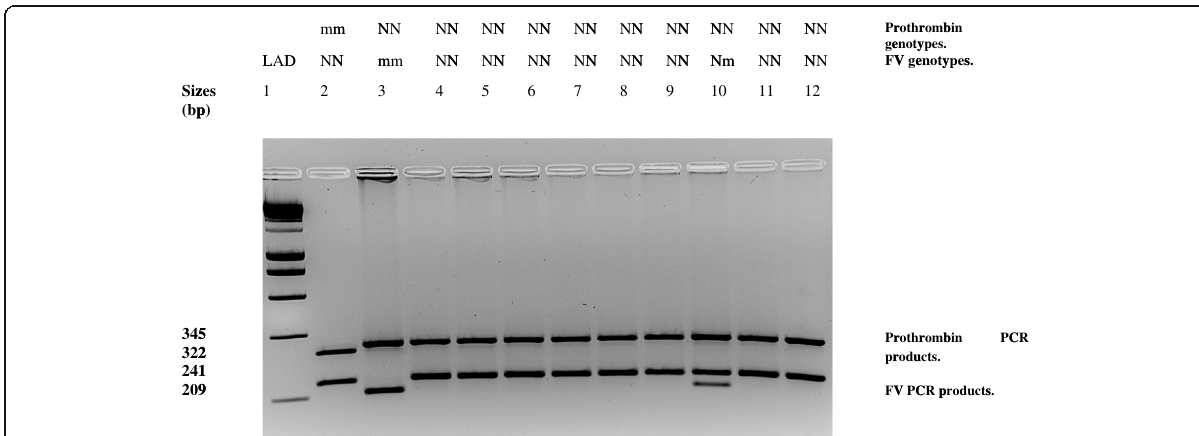
Fig. 1 Electrophoretic patterns for duplex FV and prothrombin PCR. Lane 1, size marker (1-kb ladder); lane 2, homozygous prothrombin (digested PCR products)/normal FV (undigested PCR products); lane 3, normal prothrombin/homozygous FV; lanes 4 through 9, normal prothrombin/ normal FV; lane 10, normal prothrombin/heterozygous FV. The smallest restricted fragments (32 and 23 bp) are not visible on the gel. N, normal allele; m, mutated allele